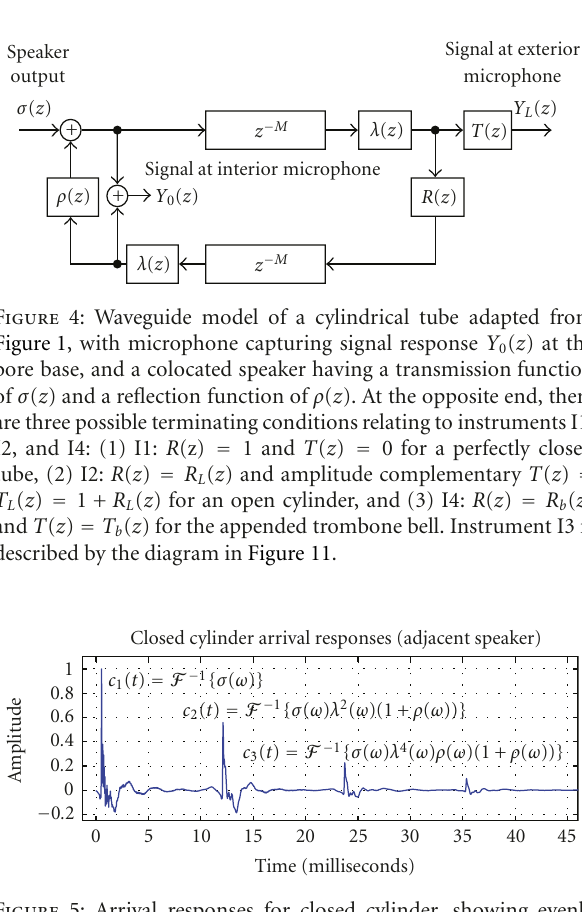
Figure 5: Arrival responses for closed cylinder, showing evenly spaced pulses as inverse transforms of combinations of transfer functions for the speaker σ ( ω ),propagationlosses λ ( ω ), and speaker reflection ρ ( ω